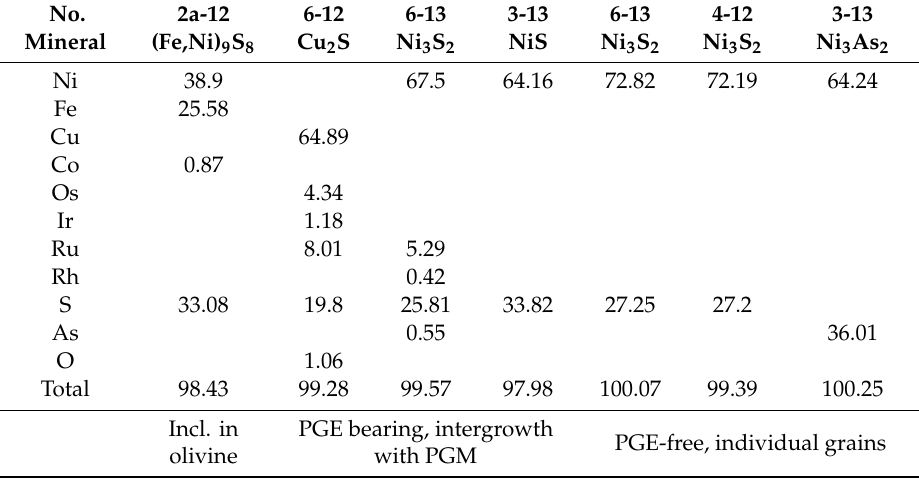
Table 5. Chemical composition of Ni, Fe, and Cu sulfides and arsenides (wt.